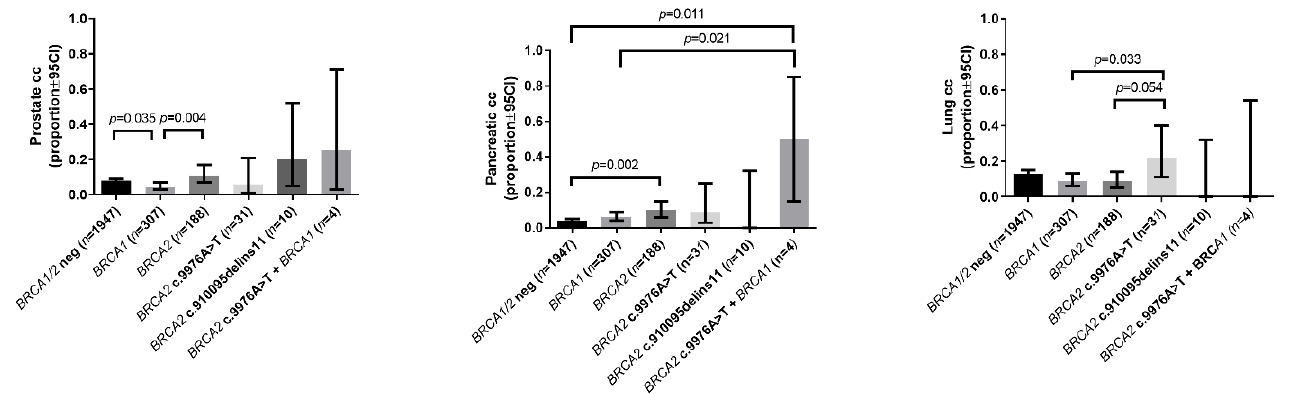
Figure 2. Prostate, pancreatic and lung cancer prevalence in HBOC probands’ families (proportions with ± 95%CI).